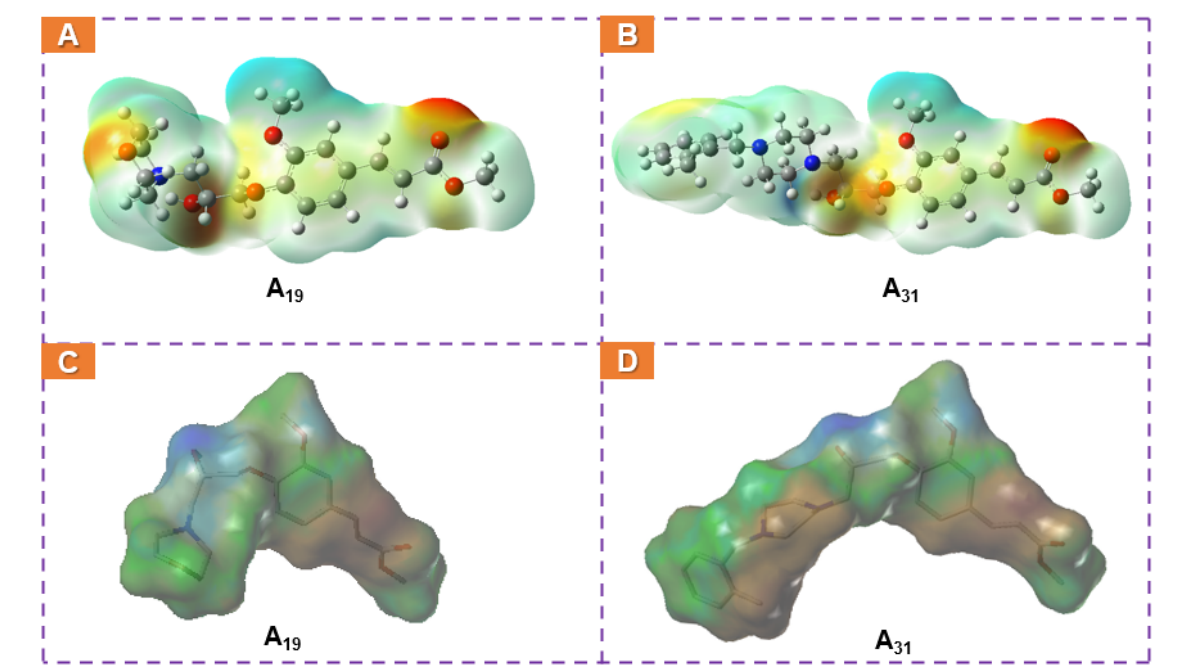
Figure 13. ( A , B ) ESP and ( C , D ) MLP of compounds A 19 and A 31